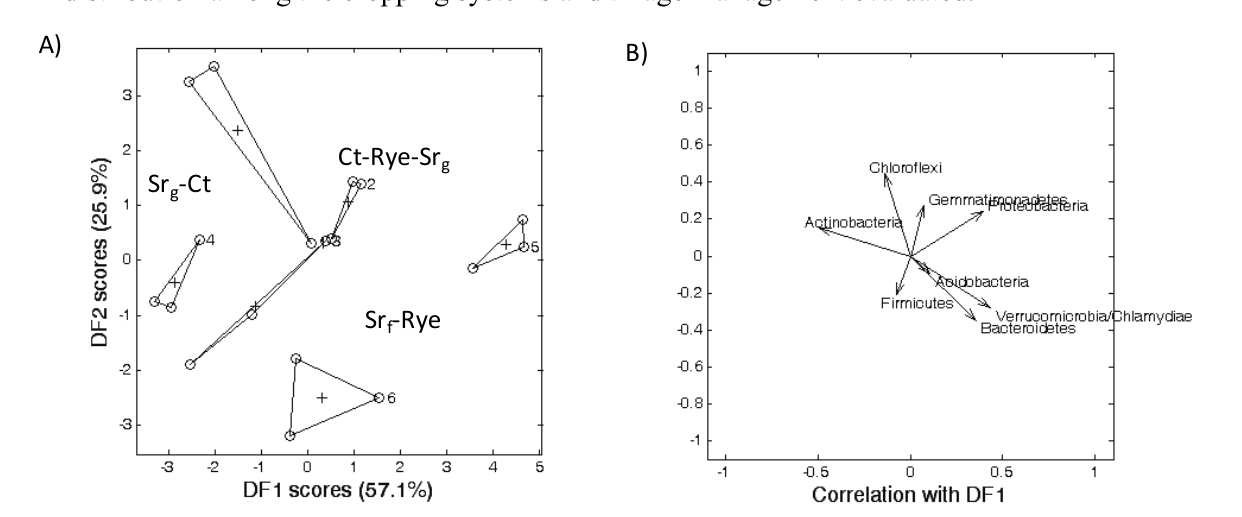
Figure 3. Discriminant function analyses (DFA) for comparing the bacterial phyla distribution among the cropping systems and tillage management